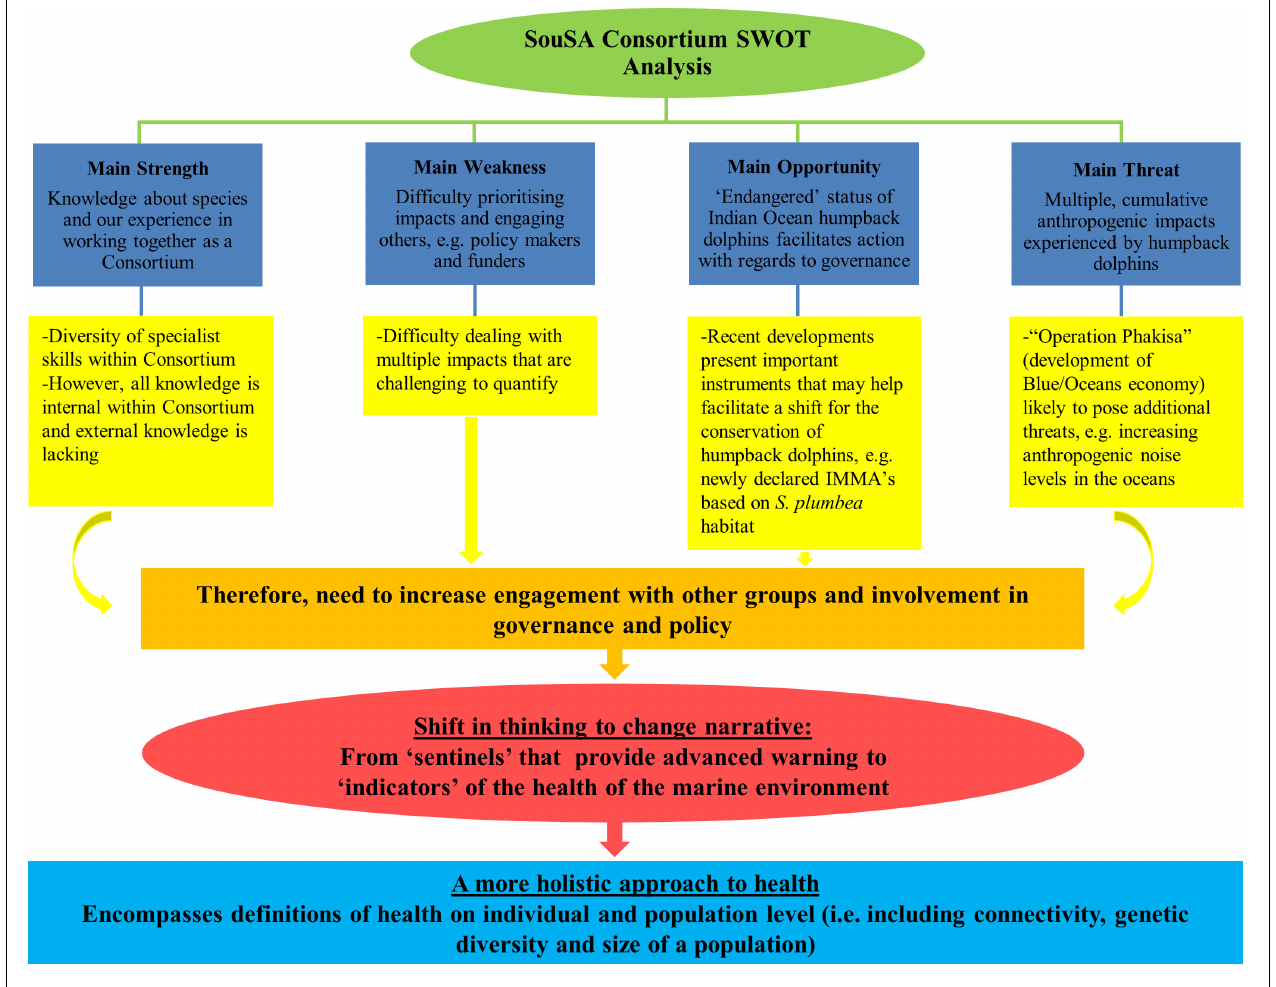
FIGURE 3 | Schematic representation of the main